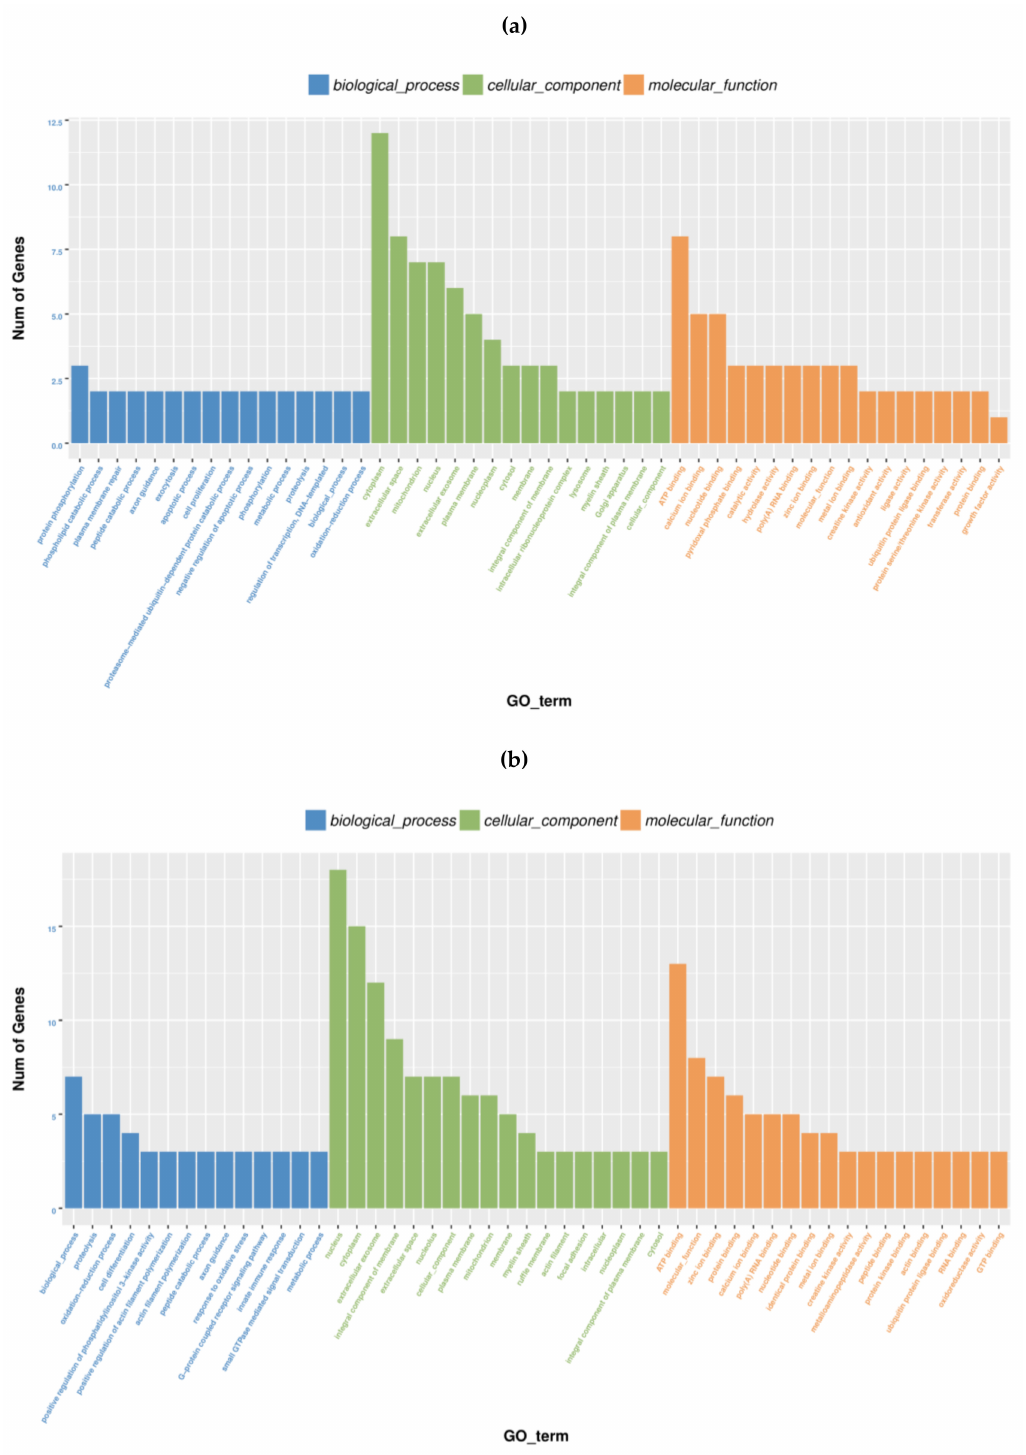
Figure 2. Distribution of gene ontology (GO) terms of DEGs during tenderization. The number of genes with GO-terms in the categories “Molecular function”, “Biological Process”, and “Cellular component” are shown. ( a ) GO functional classification of DEGs in T_1h vs. CON. ( b ) GO functional classification of DEGs in T_3h vs.